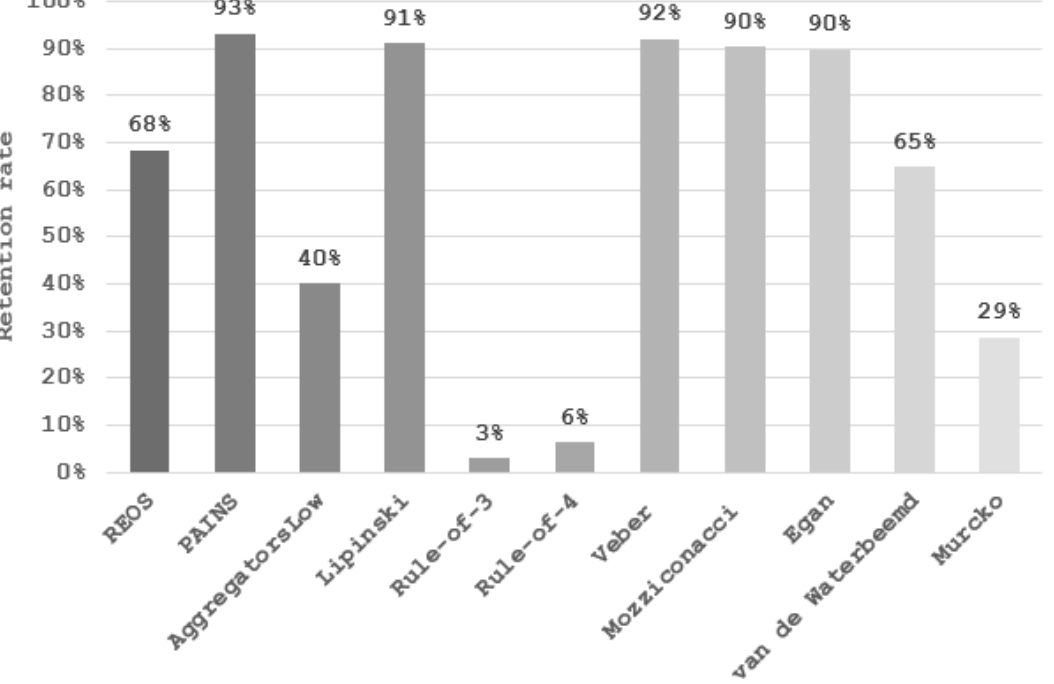
Figure 1. Percentage of compounds passing the described filters. The total number of sampled compounds of the unfiltered library is used as the denominator.